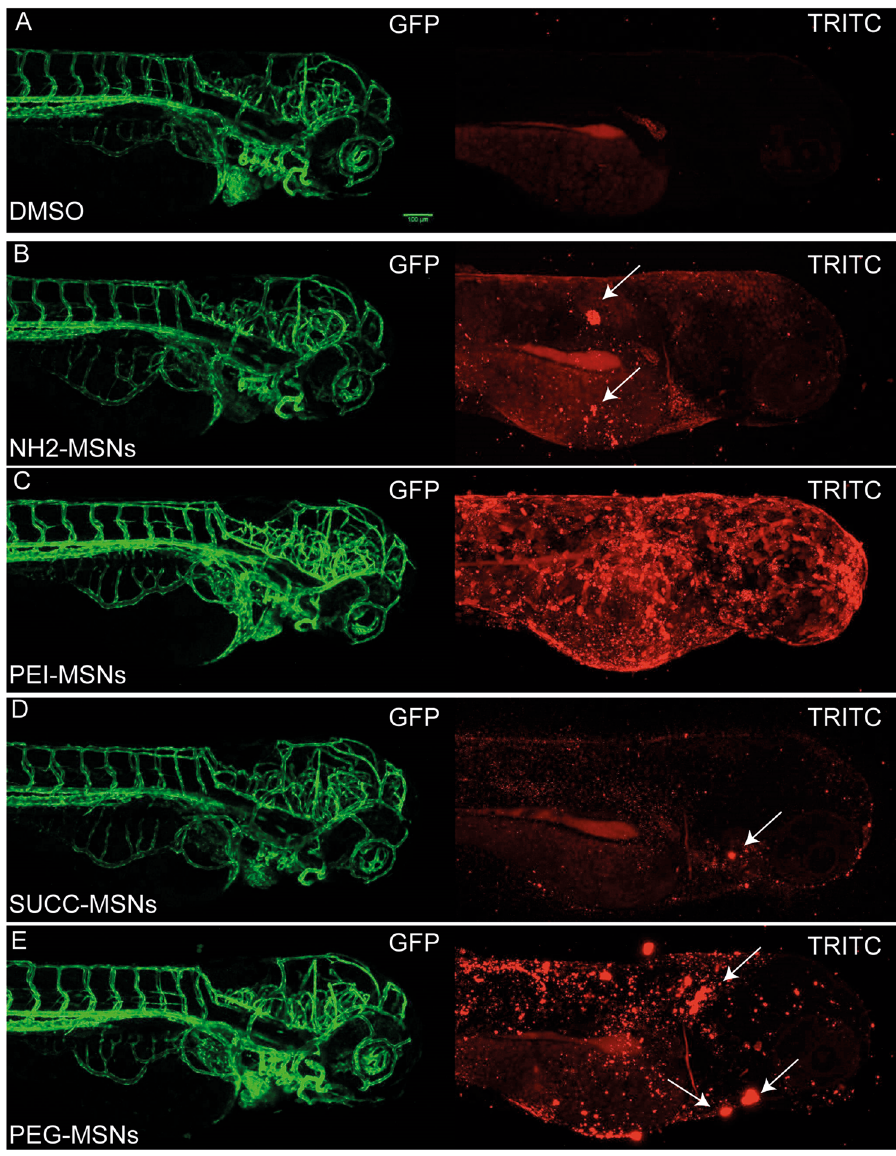
Figure 5. Surface functionalization affects aggregation of MSNs on the embryo skin. The uptake of the nanoparticles from the aquaeous medium into the embryo was analyzed by mounting anesthesized living embryos into agarose and imaged using confocal microscopy (Leica SP5 Matrix). A transgenic strain (kdrl:EGFP) expressing a GFP labeled vasculature were used 24hpf embryos were incubated 48 h with the highest tolerated dose of the different nanoparticles e.g 100 μ g/ml NH2-, SUCC- and PEG-MSNs, and 10 ug/ml of PEI-MSNs. DMSO treated embryos were used as controls and show background fluoresence ( A ). Maximum Z-projections are shown. The white arrows mark nanoparticle clusters on the superficial layer of the